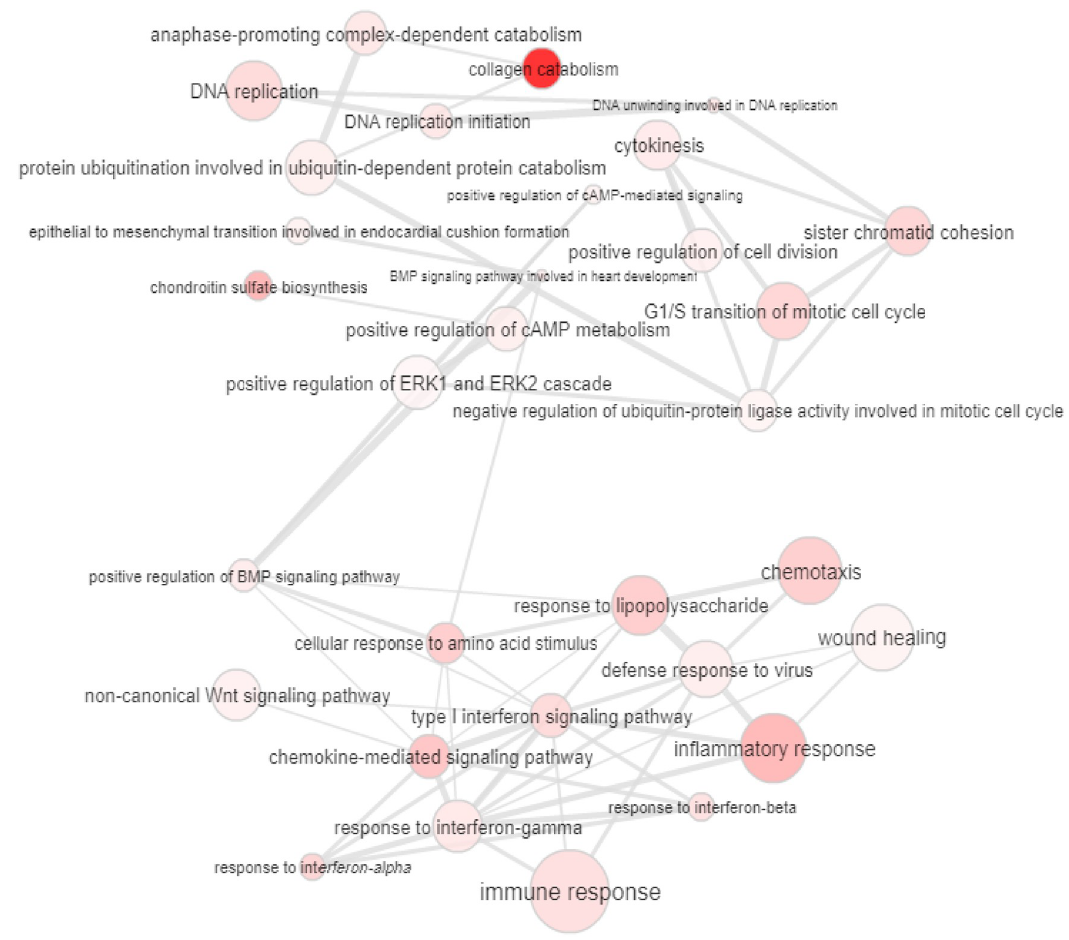
Fig 5. Interactive relationships among enriched GO terms processes in CMS4. The color and size of the nodes indicated the input p value and the frequency of the GO term generated from GOA database; edges that linked nodes in the graph indicated